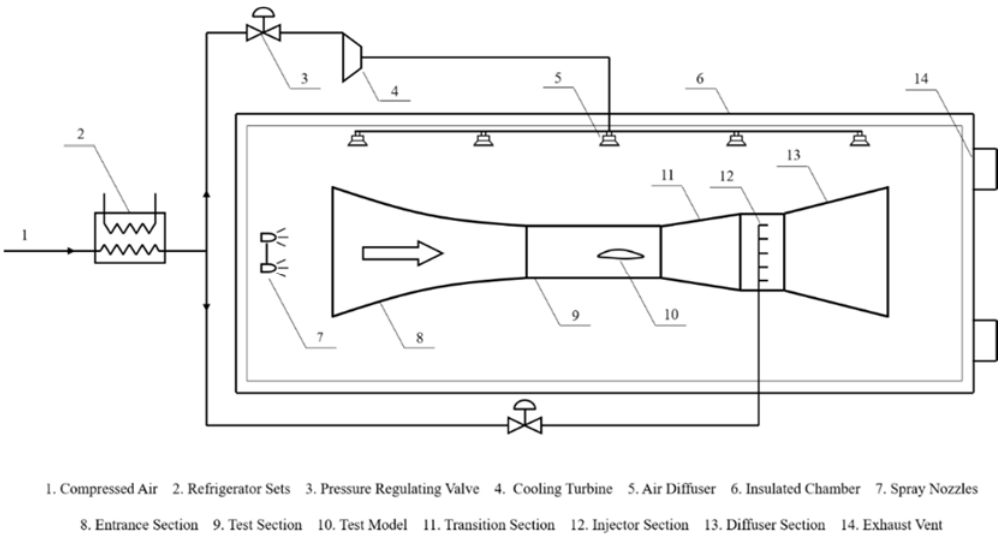
Figure 4. Schematic diagram of ejector-driven and straight-flow icing wind tunnel.